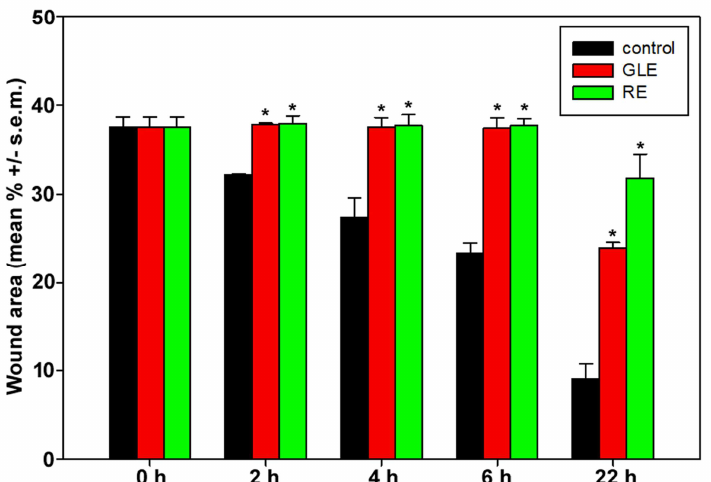
Figure 12. (Upper panel) representative phase contrast micrographs acquired during wound-healing experiments at different time intervals under control conditions and in the presence of GLE or RE at their IC 50 . The assay was performed in triplicate. Microscopic magnification = 20 × . (Lower image) bar graph summarizing the data for wound closure by control and treated cells obtained from triplicate experiments. * normality test vs. control passed.